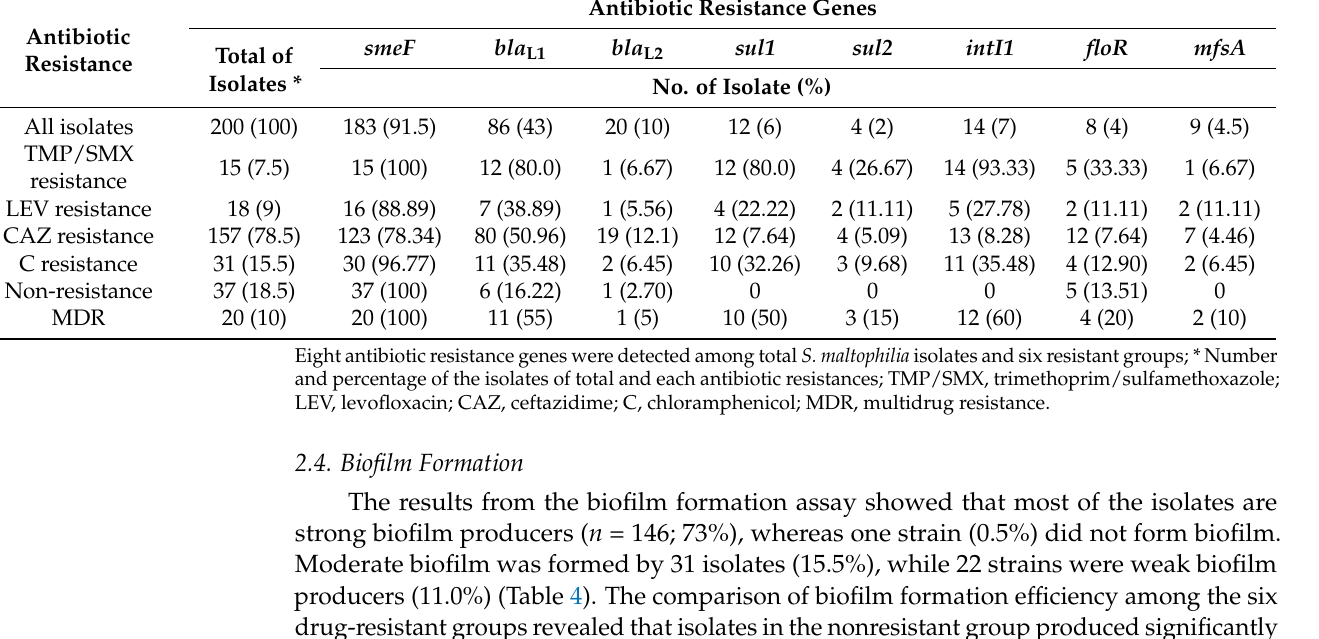
Table 3. Antibiotic resistance genes among S. maltophilia isolates are stratified into six resistance